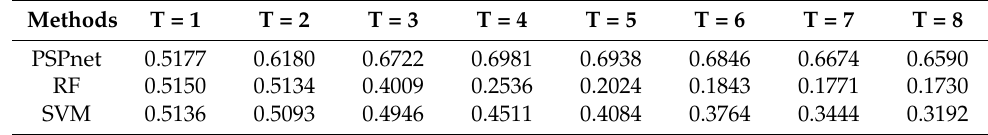
Table A11. The IoU of sample size S = 85 varies with the threshold level T.